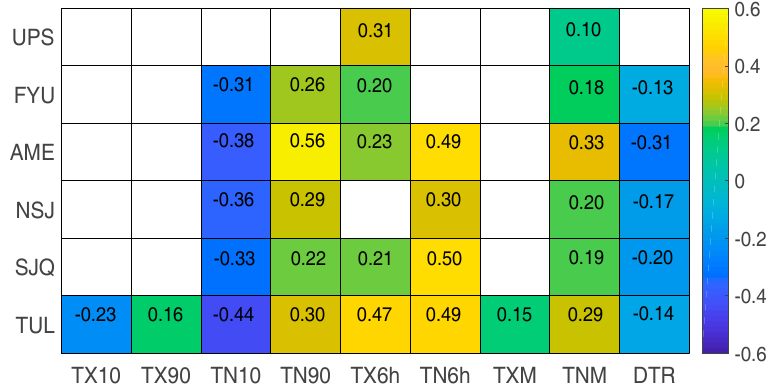
Figure 4. Slope of significant trend of temperature indices at regional (forecasting group) scale in the study period 1949–2010. Slope unit is day/year for TX10, TX90, TN10 and TN90; for other indices, the unit is °C/decade. White color indicates that there is no significant trend. Slope values of significant decreasing trends are provided.